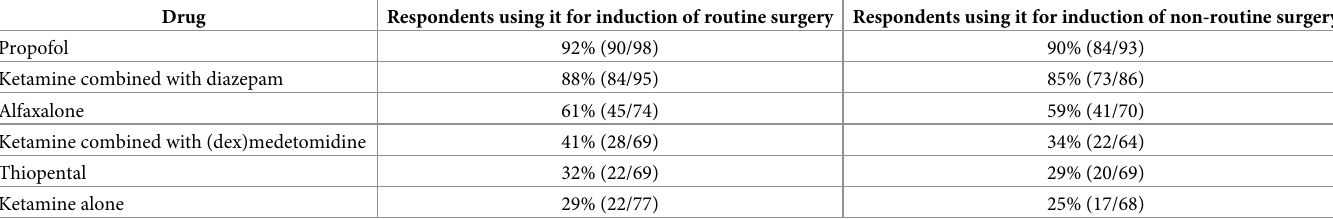
Table 5. Drugs used by English-speaking veterinarian respondents for induction of routine and non-routine surgeries. Drug Respondents using it for induction of routine surgery Respondents using it for induction of non-routine